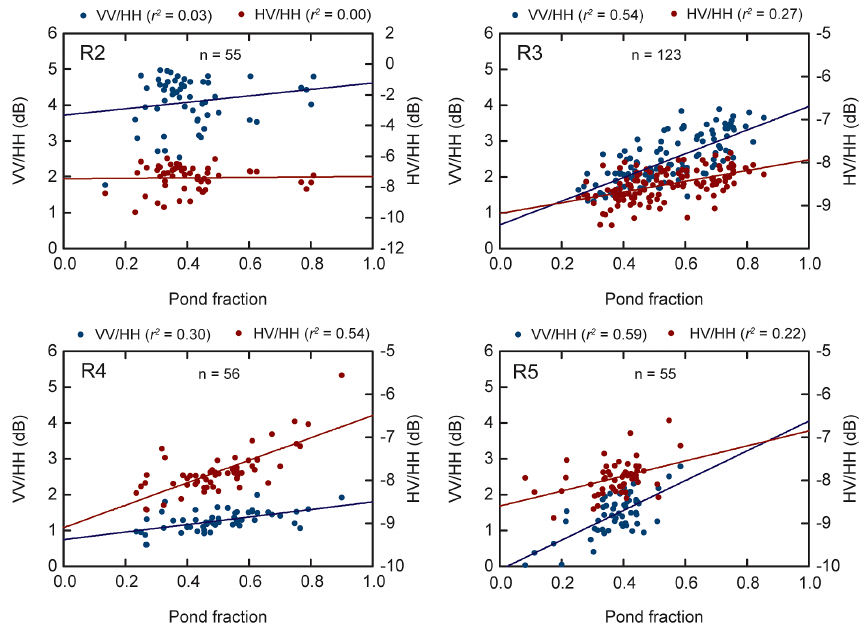
Figure 5. Scatter plots of polarimetric ratios VV / HH and HV / HH from Radarsat-2 scenes R2–R5, shown against pond fractions derived from partitioned aerial photos. Coefficients of determination between each polarimetric ratio and pond fraction are given along with the number samples in each plot.